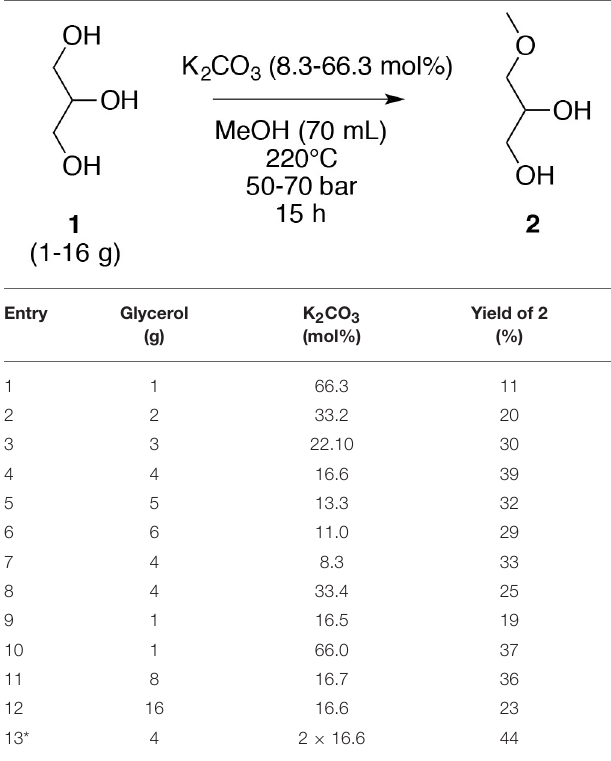
TABLE 3 | Variation of the concentration of glycerol ( 1 ) and K 2 CO 3 for the O -methylation of glycerol ( 1 ) in subcritical methanol.